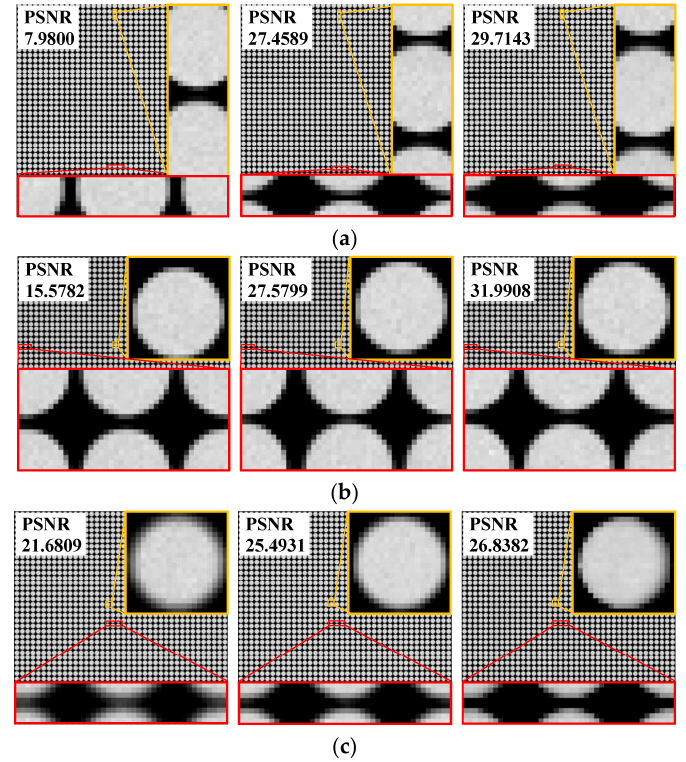
Figure 4. Comparison between partially enlarged white raw images ( a ) with a pitch error of Δ p = 1.0 μ m at α = 90°, ( b ) with a decenter error of δ = 10 at β = 90°, and ( c ) with a radius of curvature error of ε r = − 10% before and after correction. Left: distorted image; Center: corrected image using the previous method [27]; Right: corrected image using the proposed method. The PSNR values of each case are displayed in the upper left corner of the image.